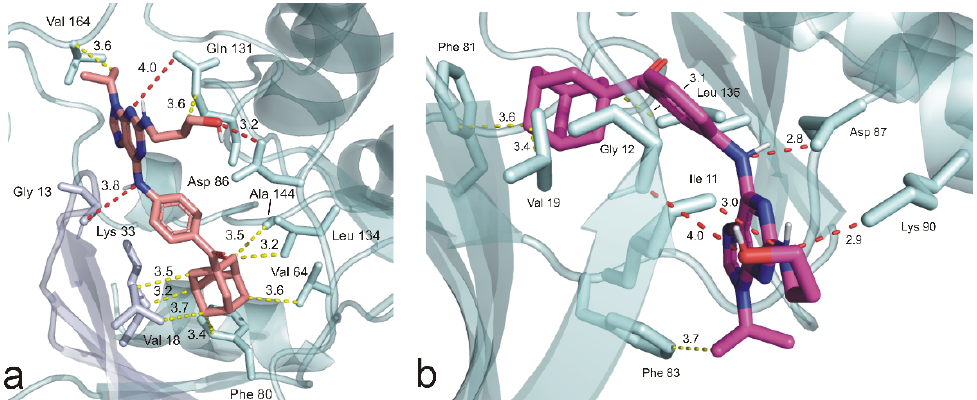
Figure 4. Purine 4d ( a ) and purine 4a ( b ) docked into the CDK2 and CDK2/cyclin E active site, respectively. Intermolecular contacts were analysed using PLIP. Non-polar contacts and H-bonds are shown as yellow and red dashed lines, respectively. Lengths are given in Å.